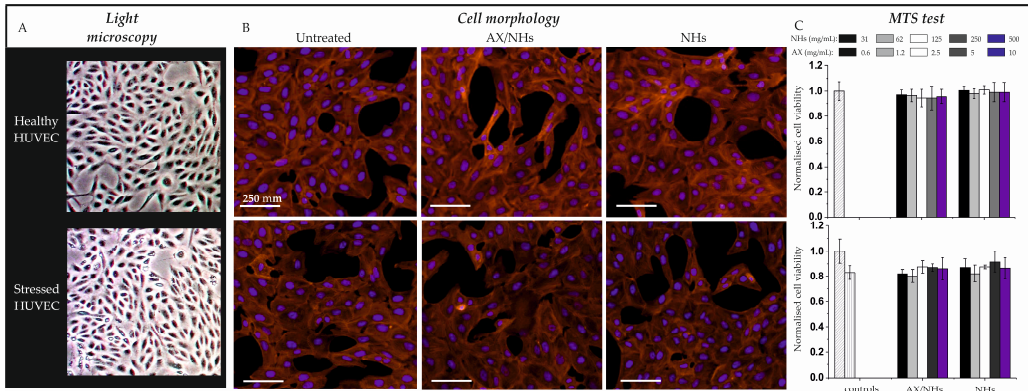
Figure 4. ( A ) Light microscopy micro-graphs of healthy or oxidatively stressed HUVECs. ( B ) Fluorescence microscopy micro-graphs (cell morphology) of healthy or oxidatively stressed HUVECs incubated with AX / NHs or free NHs at the concentration of 250 µ g mL − 1 (NHs) and 8 µ M (AX) for 24 h. Nuclei were stained with DAPI (blue), whilst actin filaments were stained with phalloidin (red). ( C ) Cell metabolism (MTS test) of healthy or oxidatively stressed HUVECs. Cells were incubated with AX / NHs or free NHs over 24 h, at several concentrations (ranging from 31 to 500 µ g mL − 1 (NHs) and from 1 to 16 µ M (AX)). Data were normalised to the negative control (HUVECs that received PBS). Statistical significance was determined with Mann-Whitney test and asterisk denote statistically significant di ff erences (* p < 0.05). Statistical significance was determined with One-way ANOVA analysis and di ff erences between the two groups were not detected. Results are expressed as the mean value ± standard deviation and experiments were performed on 8 wells ( n = 3).